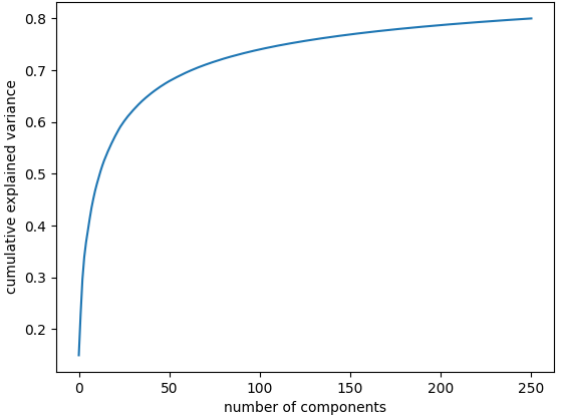
Figure 4. Cumulative explained variance: 80% of the data are represented with 250